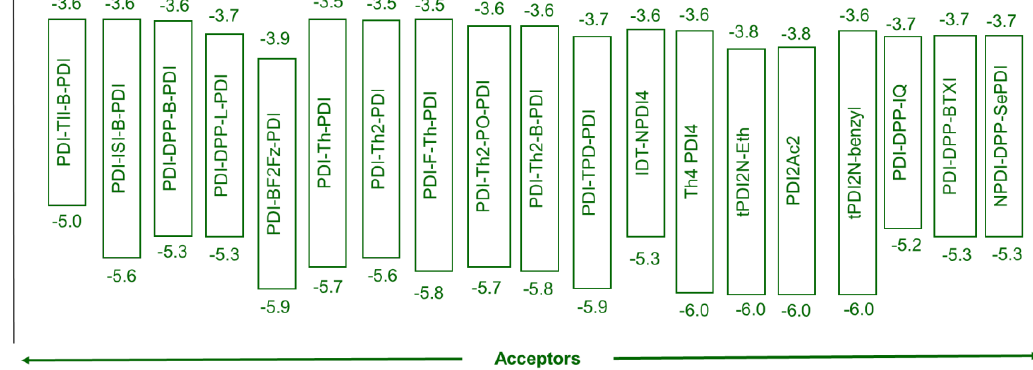
Figure 5. ( Top ) Chemical structures of donor polymers used to pair with N-annulated PDI NFAs in BHJ OPV devices. ( Bottom ) Electronic energy levels of selected N-annulated PDI NFAs presented in this review. All values determined via cyclic voltammetry (CV).